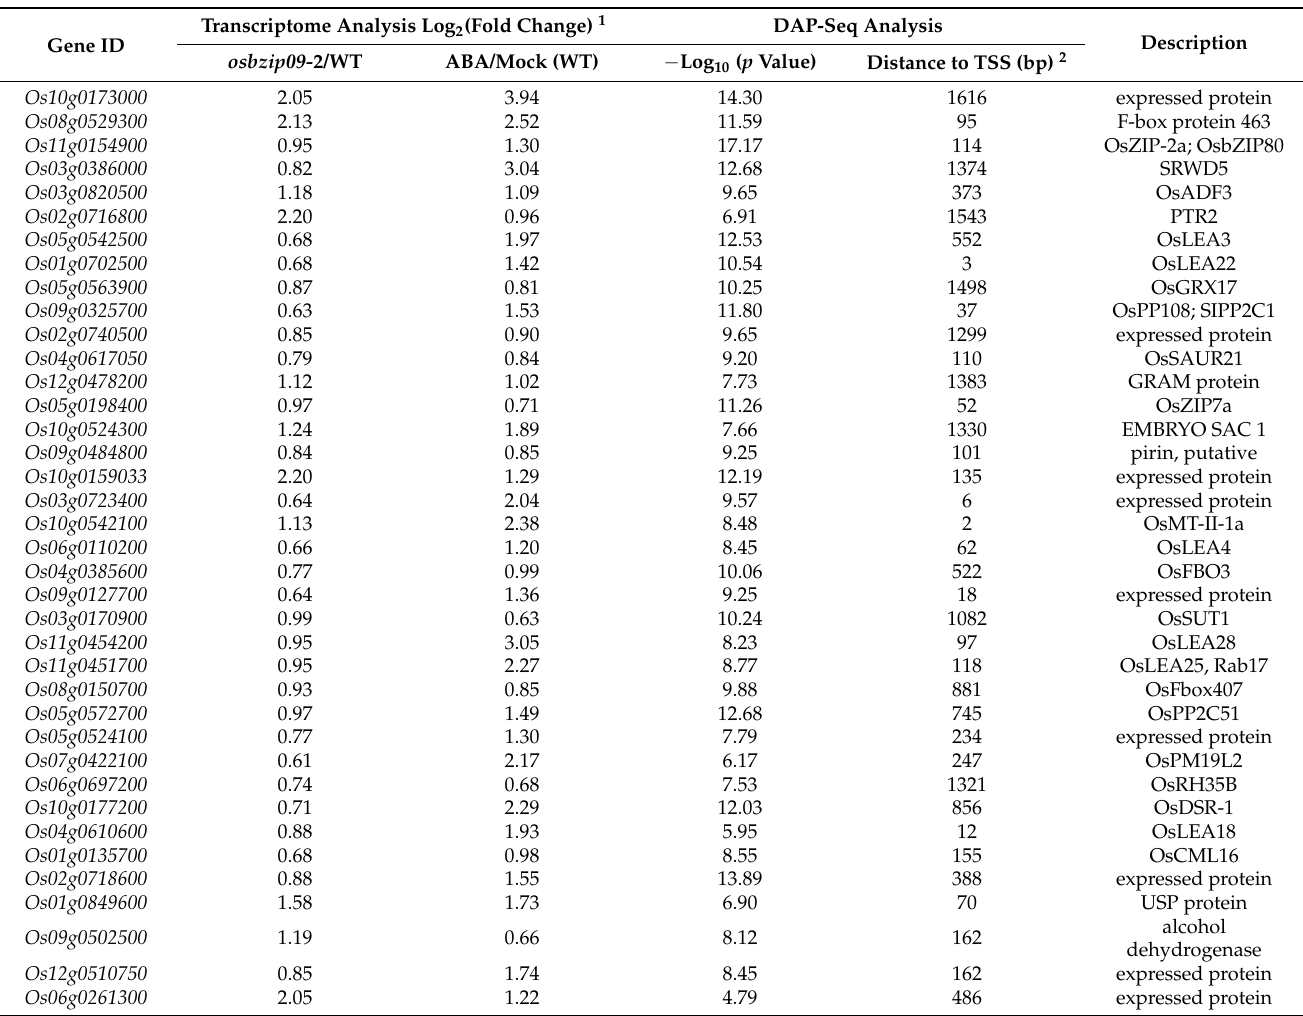
Table 1. List of OsbZIP09 target genes upregulated by ABA and in osbzip09- 2.